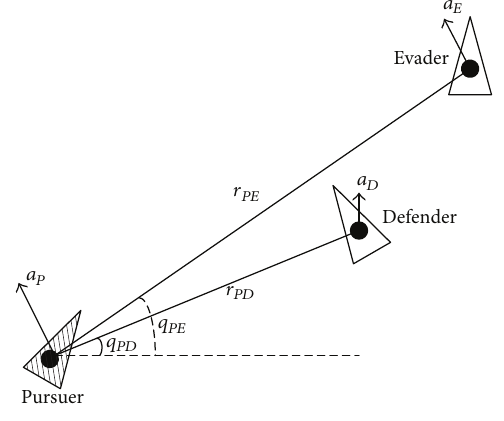
Figure 1: Triangle interception